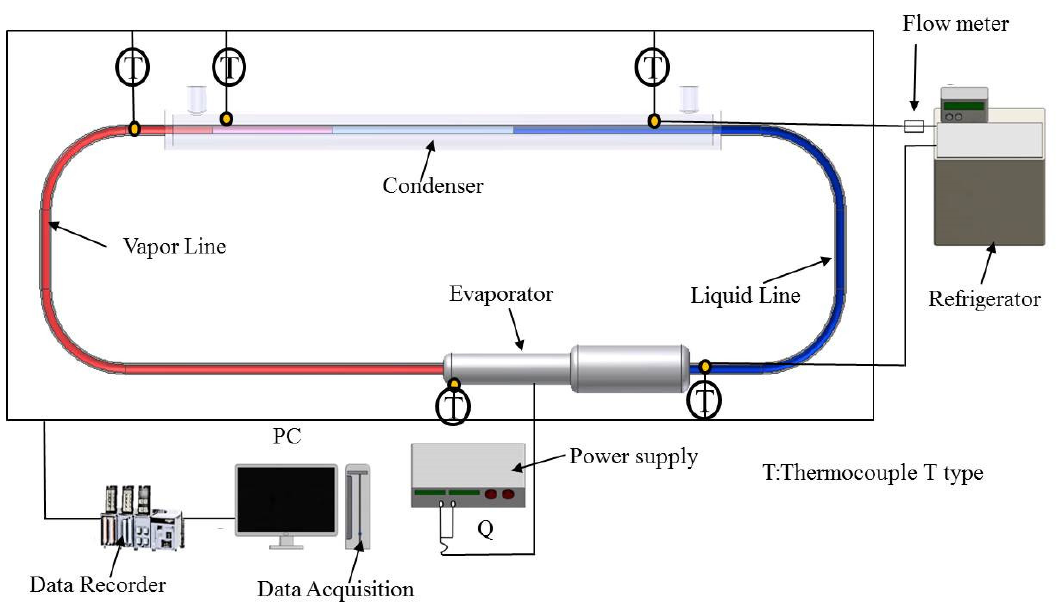
Figure 5. LHP heat transfer performance testing system setup.